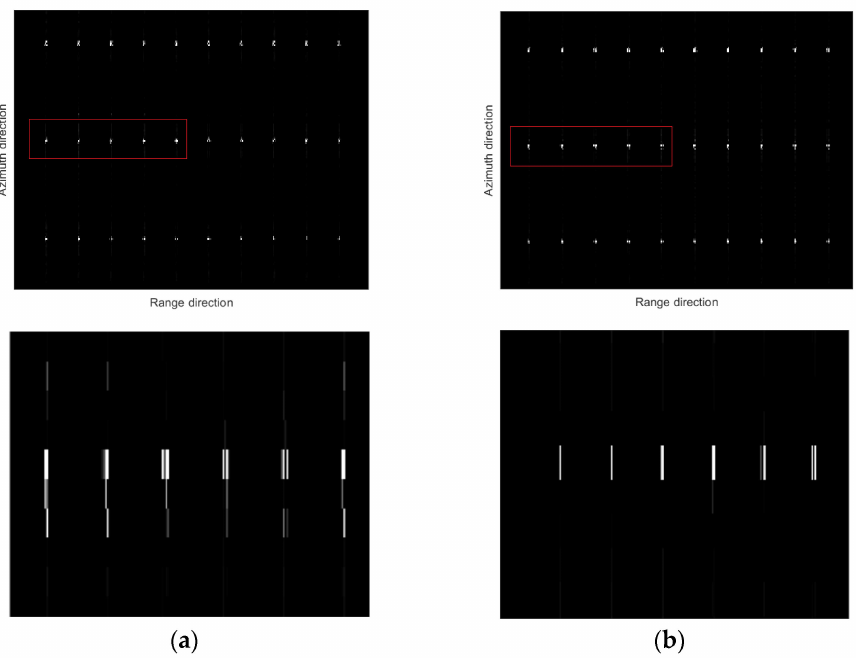
Figure 8. The sparse reconstruction diagram of each algorithm with a 0.5 echo extraction rate: ( a ) Algorithm 1, ( b ) Algorithm 2.